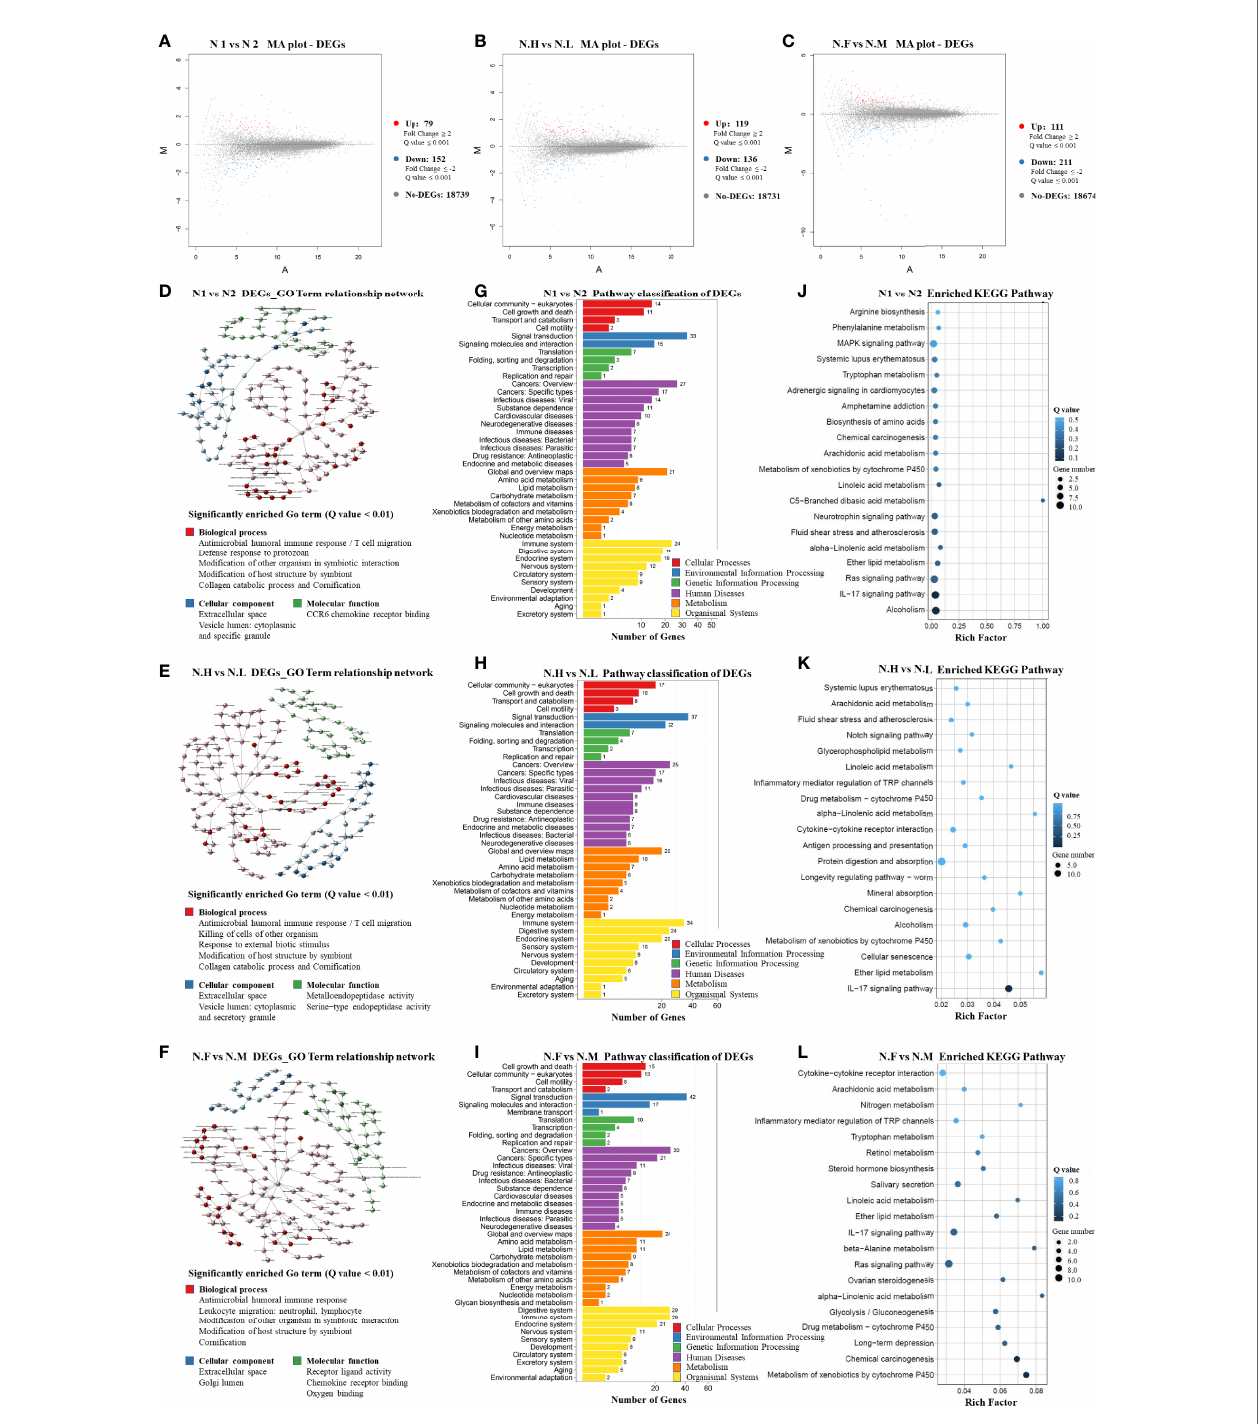
FIGURE 5 | Host normal lung tissue differentially-expressed-gene patterns (1). M-A plot of differentially expressed genes (DEGs) in three groups: (A) FLC vs Sporadic lung cancer; (B) High-IAP vs Low-IAP; (C) Female vs Male (2). DEGs GO Term relationship network in three groups: (D) FLC vs Sporadic lung cancer; (E) High-IAP vs Low-IAP; (F) Female vs Male. The detailed large fi gures were in supplementary material, Figures S5 – 7 (3). Pathway classi fi cation of DEGs in three groups: (G) FLC vs Sporadic lung cancer; (H) High-IAP vs Low-IAP; (I) Female vs Male (4). Enriched KEGG Pathway in three groups: (J) FLC vs Sporadic lung cancer; (K) High-IAP vs Low-IAP; (L) Female vs Male. N1, normal tissue of familial lung cancer; N2, normal tissue of sporadic lung cancer; N.H, normal tissue from high indoor air pollution region (High-IAP); N.L, normal tissue from low indoor air pollution region (Low-IAP); N.F, normal tissue of female lung cancer; N.M, normal tissue of male lung